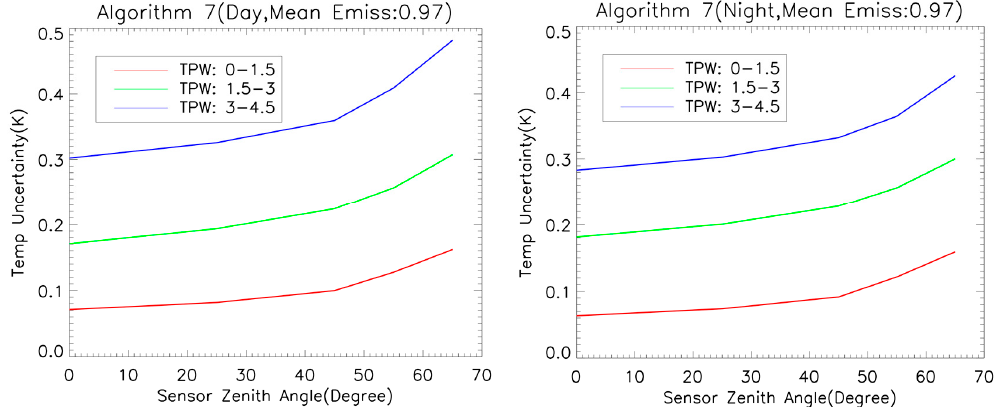
Figure3. LSTuncertaintyattributedtothesensornoiseatthreeTPWcategoriesunderday(left)andnight Figure 3. LST uncertainty attributed to the sensor noise at three TPW categories under day (left) and night (right) conditions for algorithm 7 assuming the mean emissivity of 0.97 at di ff erent viewing (right) conditions for algorithm 7 assuming the mean emissivity of 0.97 at different viewing geometries.